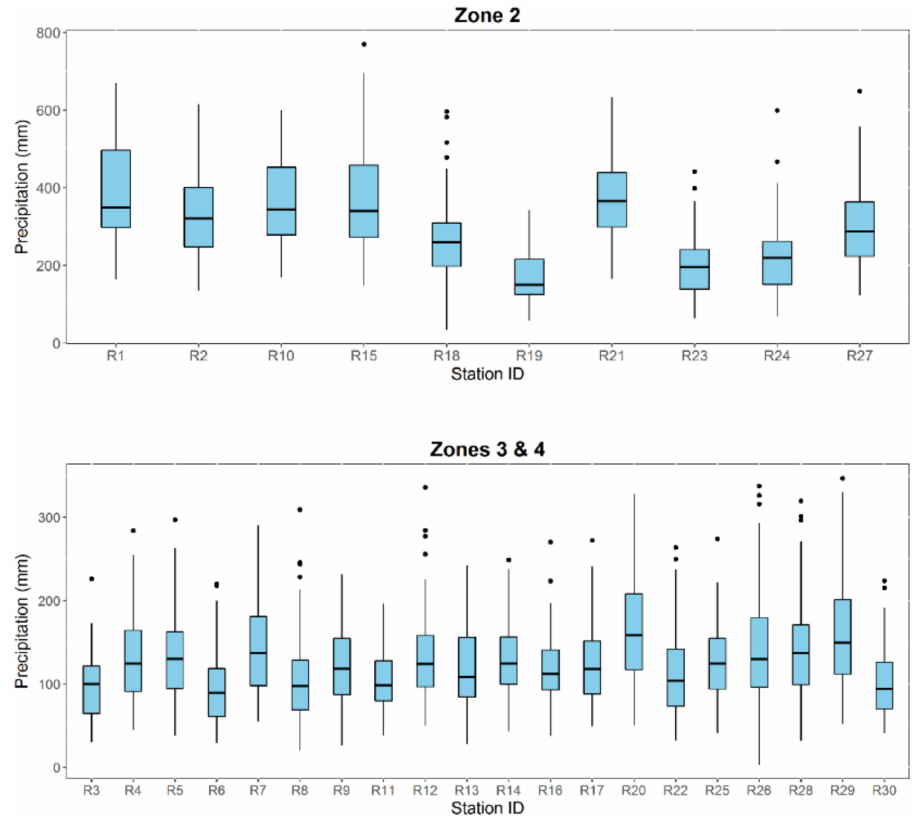
Figure 3. Box plot of observed annual precipitation in